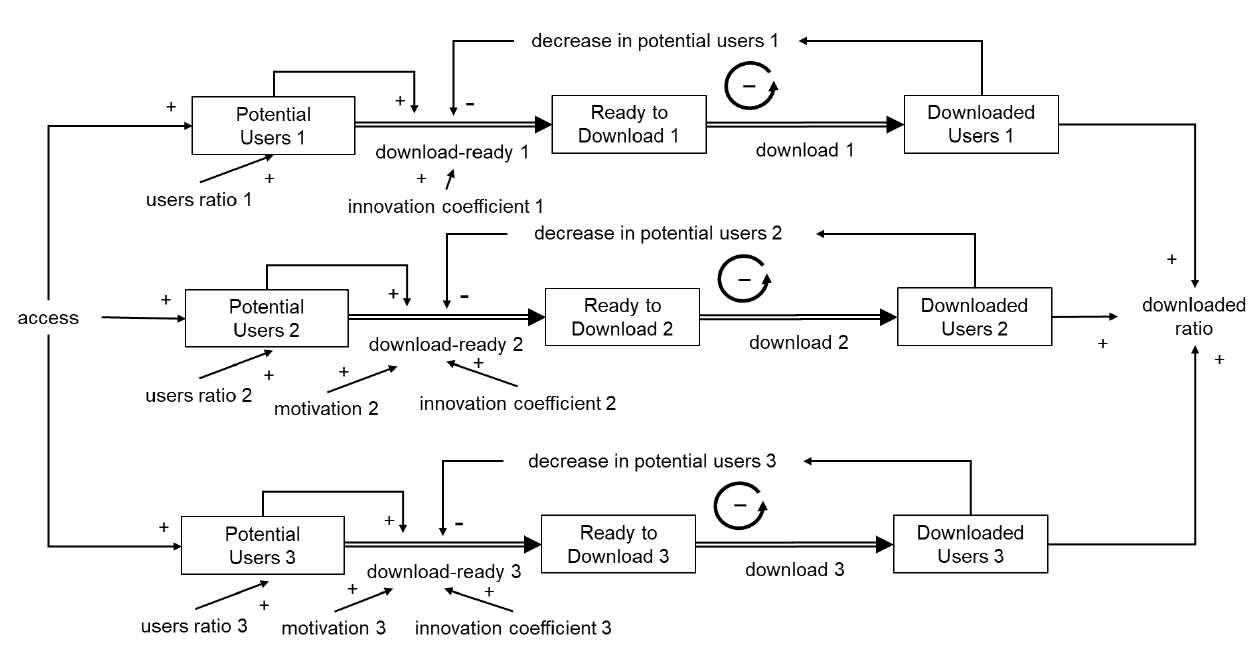
Figure 8. Conceptual system dynamics model of the number of COCOA downloads.